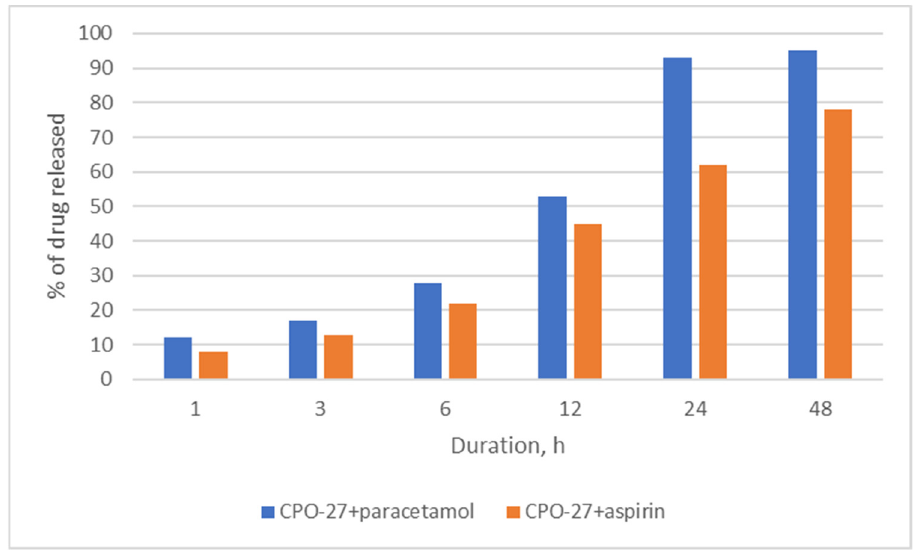
Figure 6. Release of aspirin and paracetamol from the pores of the CPO-27 material.